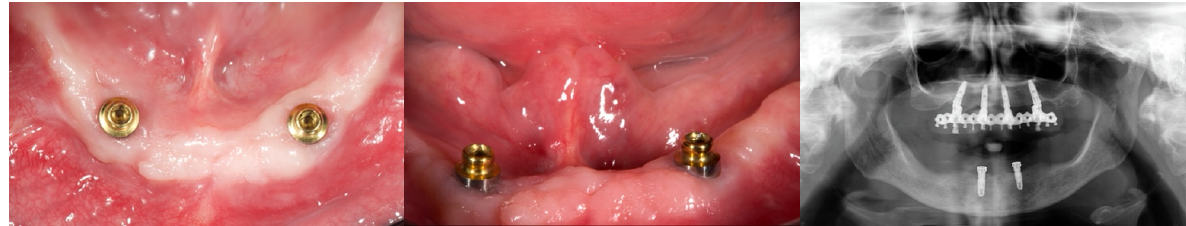
Figure 2. Explanatory case (control group).